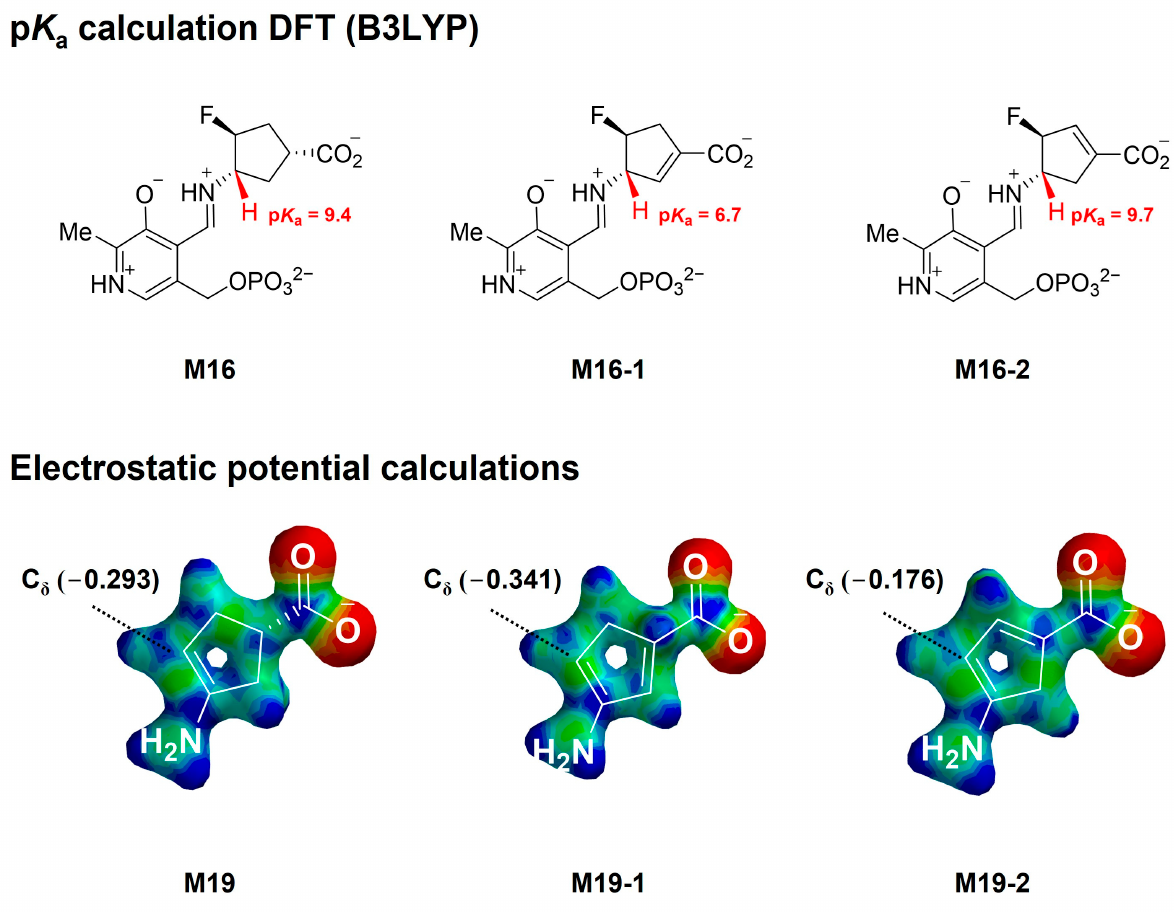
Figure 2. Theoretical p K a calculations of the hydrogen at the C γ position using ( A ) the DFT/B3LYP method and ( B ) electron density maps, color-coded according to the electrostatic potential (ESP) of intermediates and ESP charges at the C δ positions.